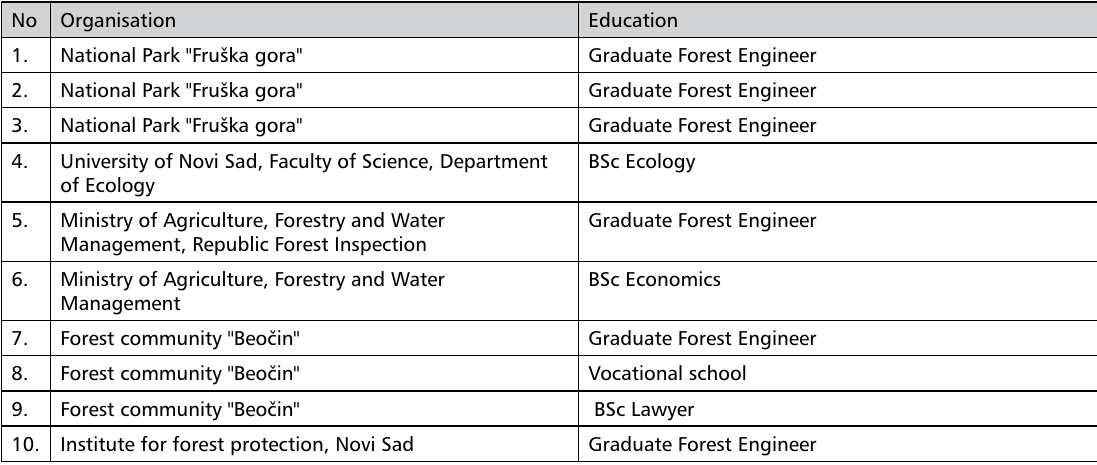
List of the interviewees in the case study NP Fruška